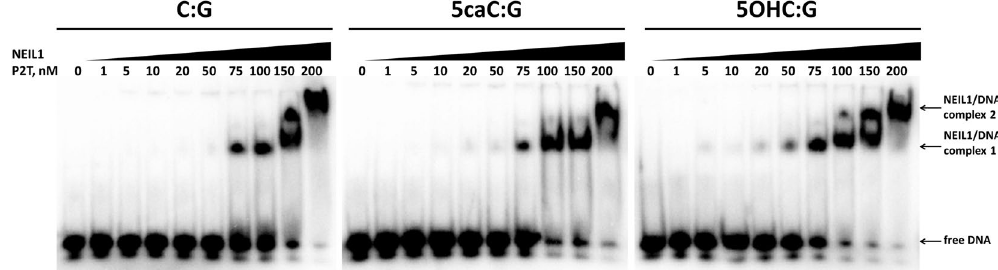
Figure 2. NEIL1 binds better to 5caC or 5OHC containing DNA than unmodified DNA: The electrophoretic mobility of 10 nM radiolabeled dsDNA containing either only unmodified bases, a 5caC base, or a 5OHC base was monitored in native conditions in the presence of increasing amounts of the inactive NEIL1 P2T variant (to prevent DNA cleavage during the experiment) by autoradiography. We have observed the formation of NEIL1/ DNA complex (1) and supercomplex (2) at lower protein concentration with an oligo containing 5OHC:G (positive control) or 5caC:G (experiment) than in case of the oligo containing C:G. Moreover we can also observe the disappearance of free DNA that contained 5OHC:G and 5caC:G at lower NEIL1 P2T concentration than in case of DNA containing